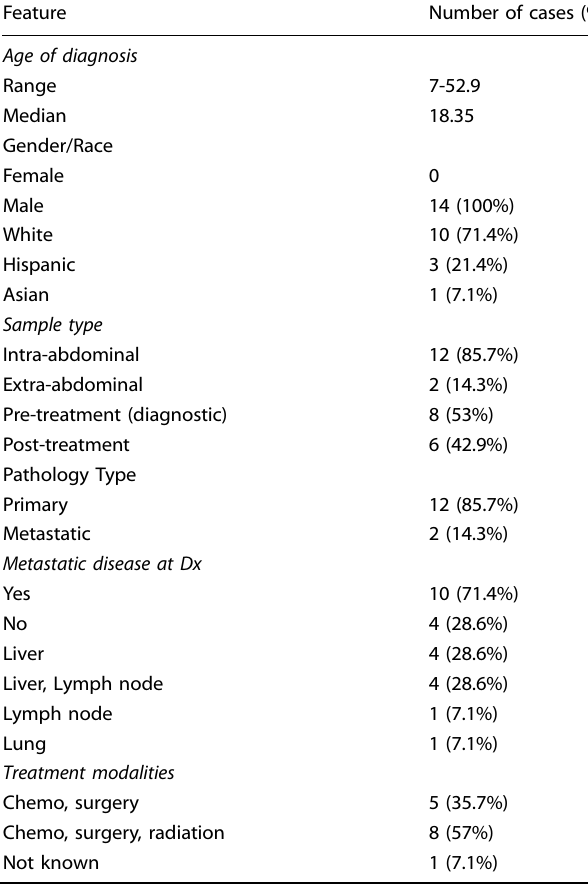
Table 1. Clinicopathologic characteristics of 22 DSRCT samples from 14 patients.